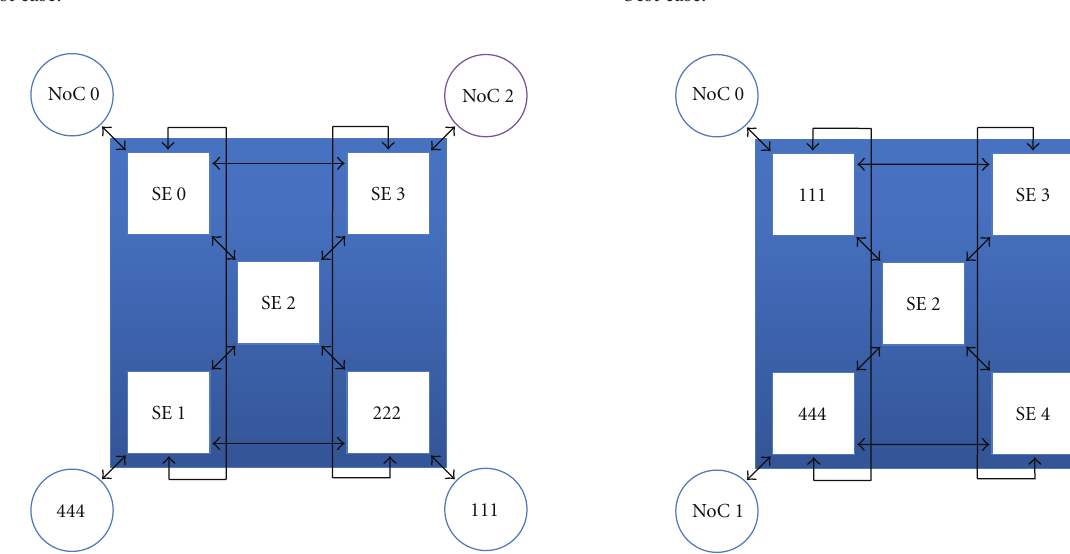
Figure 10: The simulation state of NiP-PNN model at third step of best case.